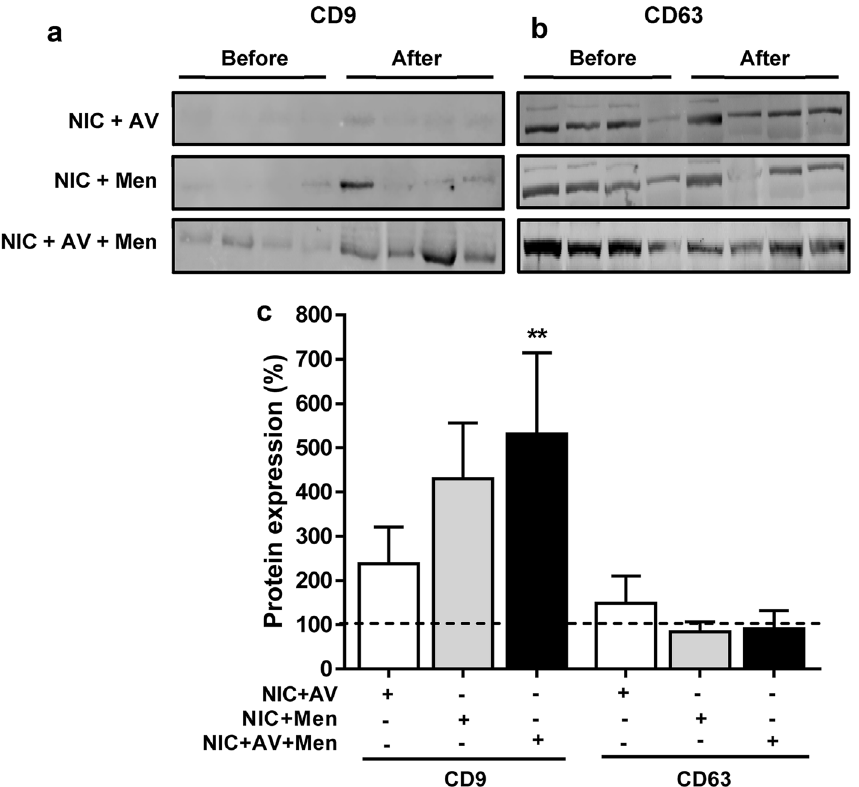
Figure 2. Expression of proteins in EVs. EVs were isolated from rat plasma obtained ‘before’ and ‘after’ self- administered nicotine in the presence of either AV, menthol or combined (NIC: Nicotine, AV: Audiovisual, Men: Menthol). Representative western blots of CD9 ( a ) and CD63 ( b ). The ‘before’ represent the plasma EVs obtained before the self-administered nicotine, whereas ‘after’ represent plasma EVs obtained after the self- administered nicotine with menthol and AV cue alone or combined. ( c ) Densitometry analysis. Plasma EVs obtained ‘before’ self-administered nicotine were considered as 100%. Statistical analyses were carried out by using one-way ANOVA. Results are expressed as means ± S.E.M of n = 4 experiments. **p < 0.01, in comparison with ‘before’ nicotine